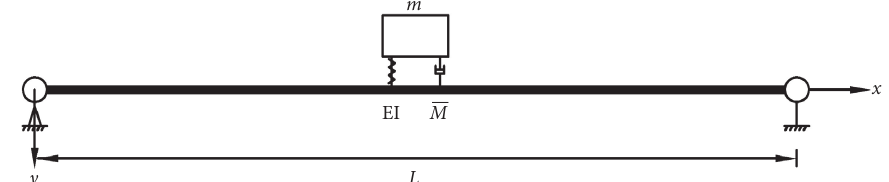
Figure 12: The simplified model of a pedestrian bridge with an